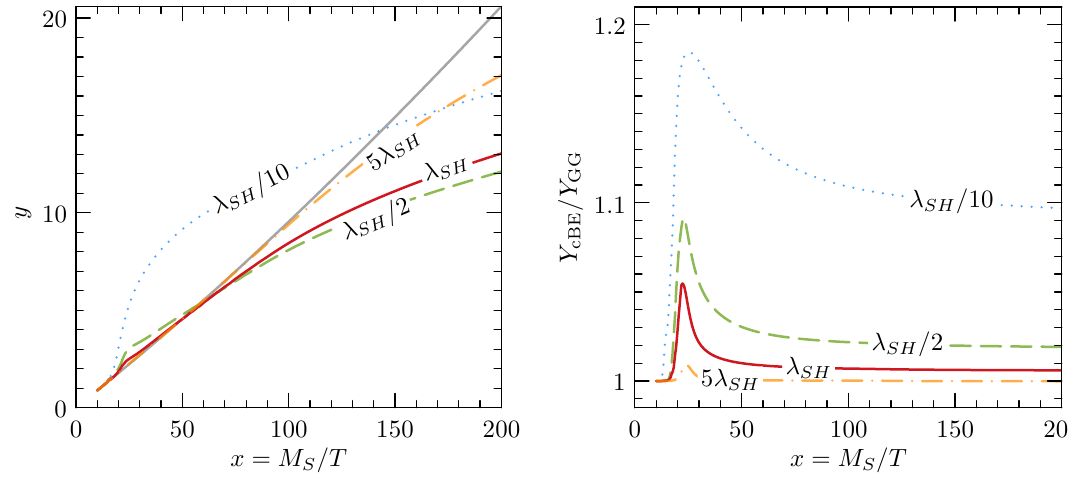
Figure 2 . The evolution of DM temperature and comoving number density for an example point in the semi-annihilation regime with M S = 132 : 5 GeV. Left: a clear departure from kinetic equilibrium (gray solid line) is seen for (cid:21) SH = 7 : 08 10 (cid:0) 3 that gives the correct relic abundance (cid:2) (red solid), as well as if its value is modi(cid:12)ed to be 5 times larger (yellow dot-dashed), 2 or 10 times smaller (green dashed and blue dotted, respectively). The bump around x 20 is due to (cid:25) ‘self-heating’ caused by semi-annihilation and gets more pronounced, the more suppressed are the elastic scatterings. Right: the di(cid:11)erence between the cBE and standard Gelmini&Gondolo [75] treatment for the same set of values of (cid:21) SH . The smaller the Higgs portal coupling, the larger the impact of the (cid:12)nal relic